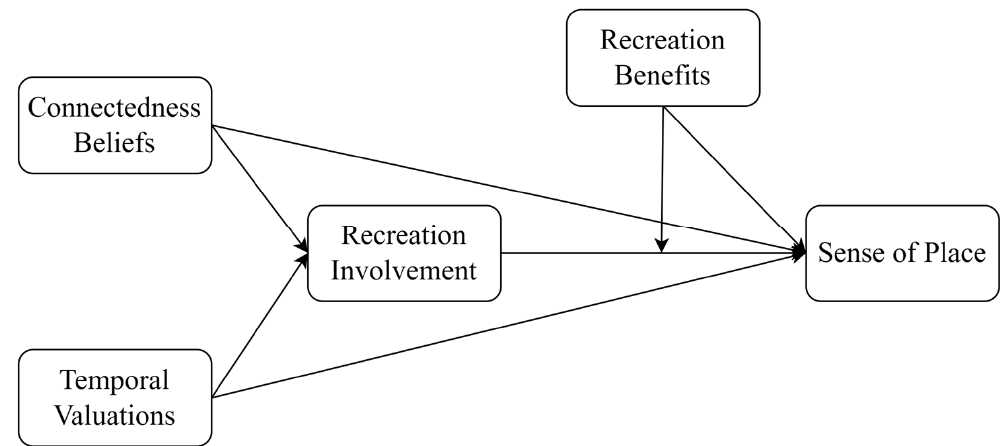
Figure 2. Theoretical model.